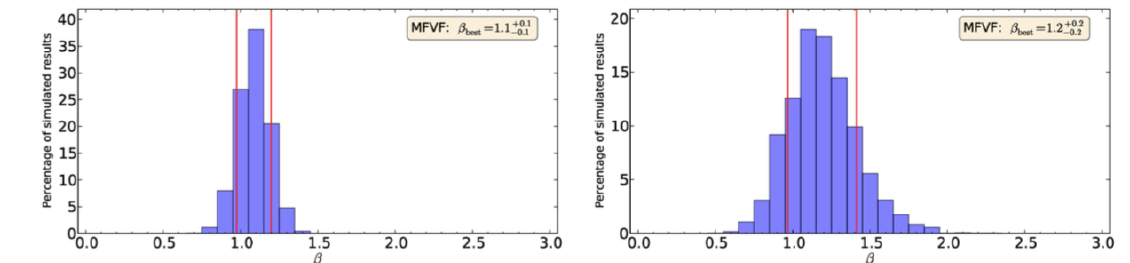
Figure 8. Best-fit parameters and uncertainties for the power-law noise index β for the long-term gamma-ray activity in PKS 2155-304 estimated from simulated light curves. Left: For VHE (H.E.S.S.) data. Right: For HE (Fermi-LAT) data. The vertical red bars indicate the 1 σ uncertainties on the best fit. Both the VHE and the HE variability are compatible with flicker noise β = 1. From [39].